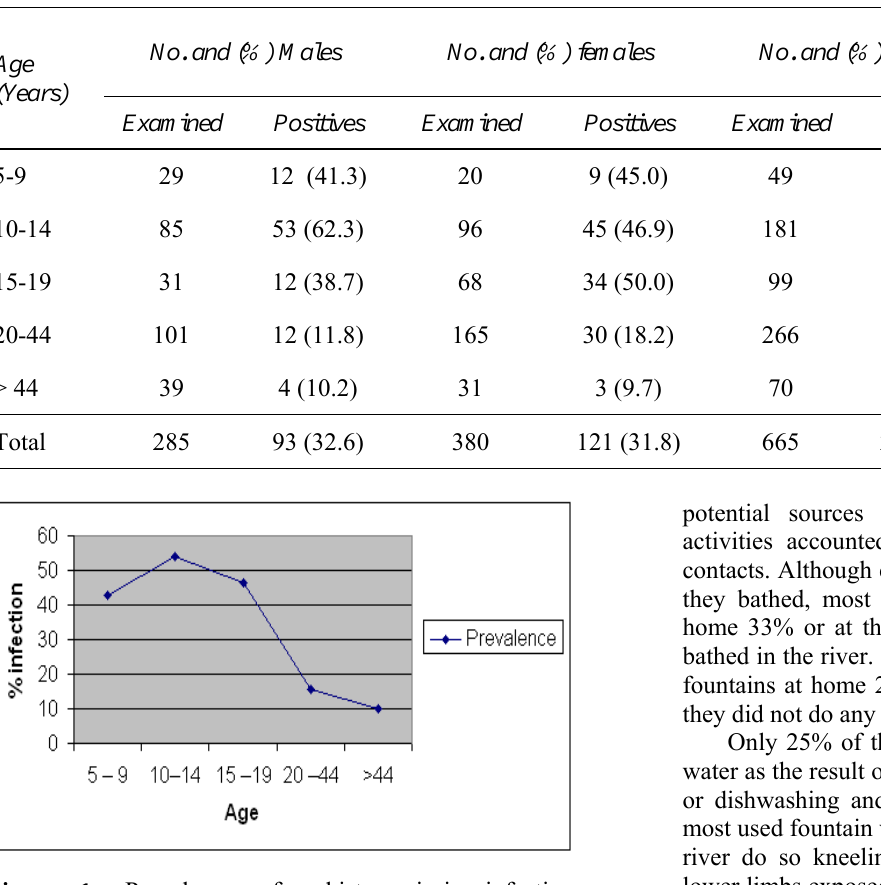
Figure 1: Prevalence of schistosomiasis infection according to age